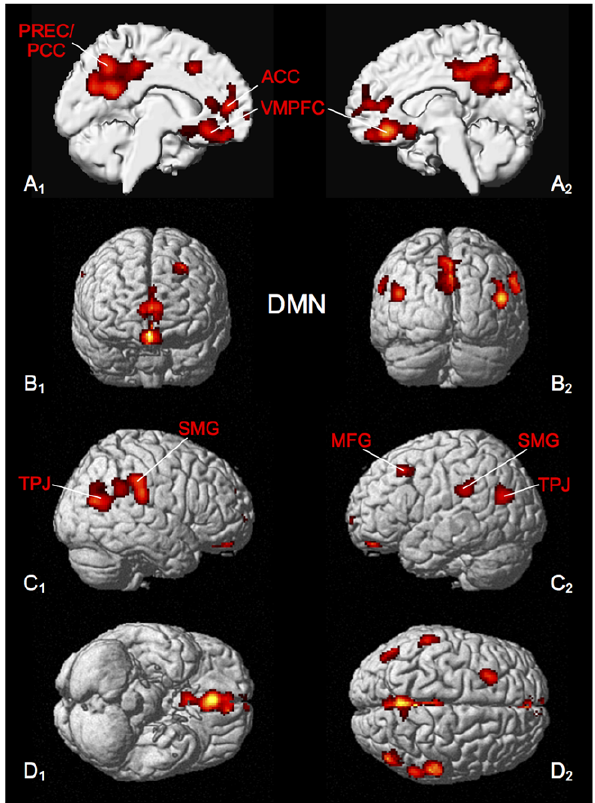
Figure 3. Significant results of the ALE meta-analysis of unconstrained cognition (DMN). All results are displayed on the left and right lateral surface view, the anterior/posterior and dorsal/ ventral view of the MNI single subject template. ACC: anterior cingulate cortex, MFG: middle frontal gyrus, PCC: posterior cingulate cortex, PREC: precuneus, SMG: supramarginal gyrus, TPJ: temporo-parietal junction, VMPFC: ventro-medial prefrontal cortex. doi:10.1371/journal.pone.0030920.g003 PLoS ONE |